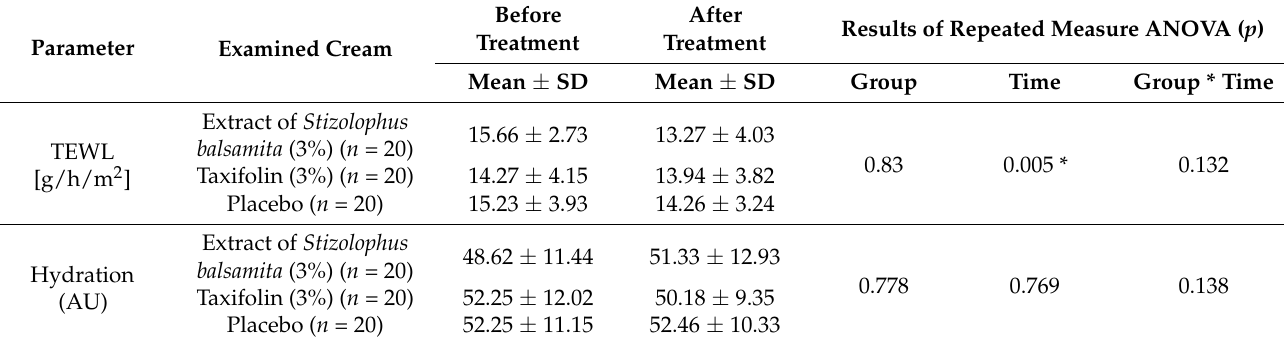
Table 3. Detailed results of skin biophysical parameters comparison before and after treatment with the Stizolophus balsamita extract and taxifolin.